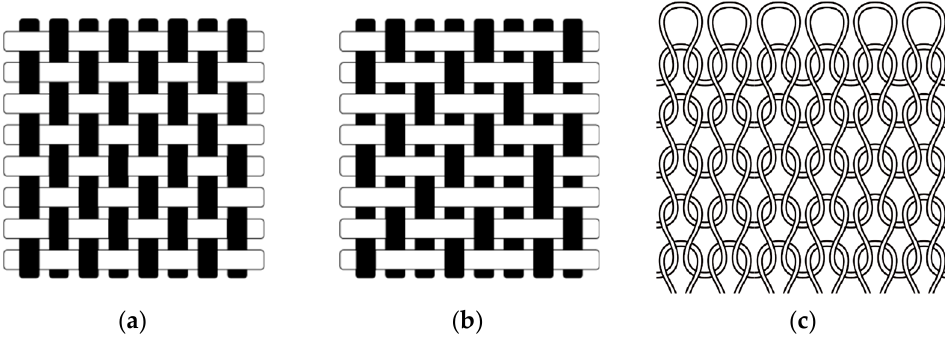
Figure 4. Fabric constructions of two woven fabrics and one plain-knitted fabric. ( a ) The plain-woven fabric with a 1:1 intersecting point. ( b ) Twill-woven fabric made by passing the weft thread over one or more warp threads, then under two or more warp threads. ( c ) Plain-knit fabric formed with loops that are loosely connected.